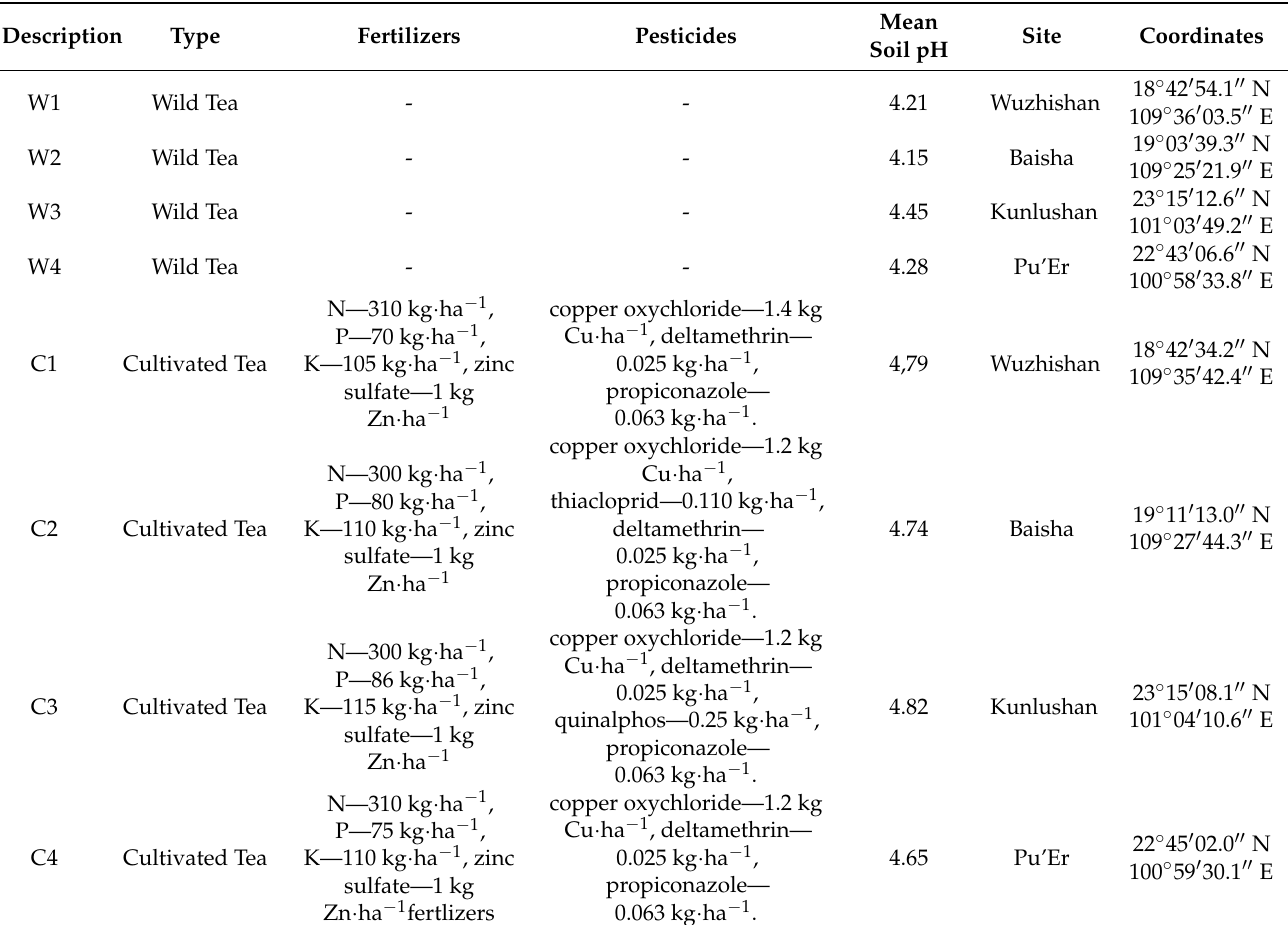
Table 1. Locations of sample